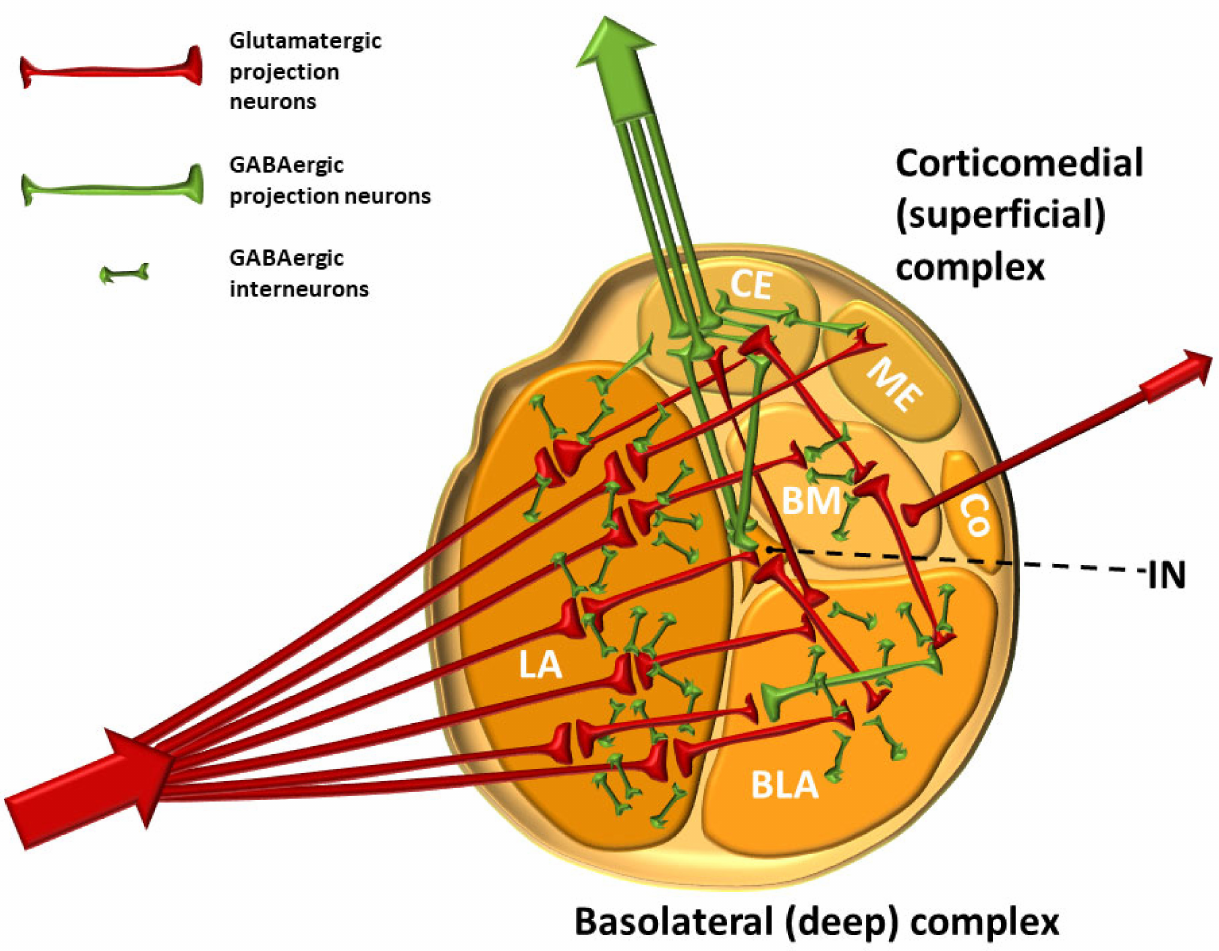
Figure 7. Simplified neuroanatomical representation of information flow within the amygdala. BLA—basolateral nu- cleus of the amygdala; CE—central nucleus of the amygdala; Co—cortical nucleus of amygdala; IN—intercalate neurons; LA—lateral nucleus of amygdala; ME—medial nucleus of amygdala; BM—basomedial (accessory basal) nucleus of the amygdala. The schematics is made according to Wieronska et al., (2010) [148], Orsini and Maren (2012) [111], Benarroch (2015) [149], Gilpin et al., (2015) [116], Janak and Tye (2015) [147], and Sangha et al., (2020)